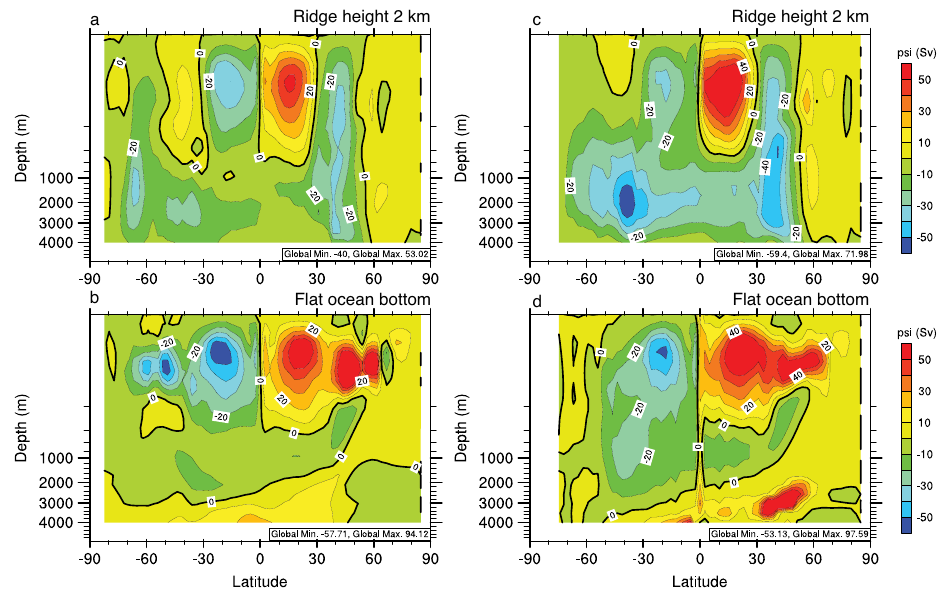
Fig. A4. The zonally integrated total (Eulerian plus eddy-induced) Meridional overturning circulation (MOC) for the 720Ma ( a and b ) and 570Ma continental configurations ( c and d ). The upper and lower panels were obtained by RIDGE method and DIF method, respec- tively. Note that the maximum value for the 570Ma continental configuration ( c and d ) is much larger than that for the 720Ma continental configuration ( a and b ) due to eddy-induced circulation (not shown). TSI = 0.94TSI 0 , τ = 0 . 12, p CO 2 = 2000 ppmv for all four